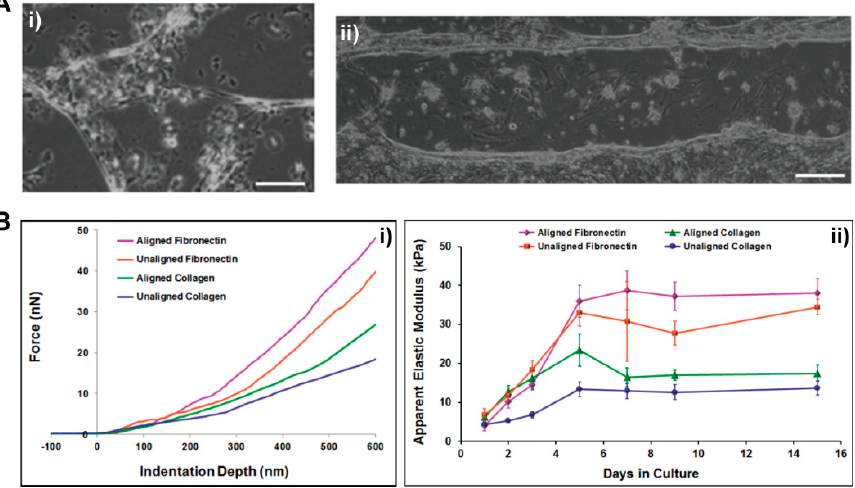
Figure 10. ( A ) Brightfield microscopy images of cardiomyocytes on unaligned (i) and aligned (ii) Figure10. ( A )Brightfieldmicroscopyimagesofcardiomyocytesonunaligned(i)andaligned(ii)collagen collagen matrices. ( B ) Measurement of force (i) and elastic moduli (ii) on different substrates. Scale matrices. ( B ) Measurement of force (i) and elastic moduli (ii) on di ff erent substrates. Scale bar: 20 µ m. bar: 20 μ m. Reprinted from [76]. Copyright (2012) Tech Science Press. Reprinted from [76]. Copyright (2012) Tech Science